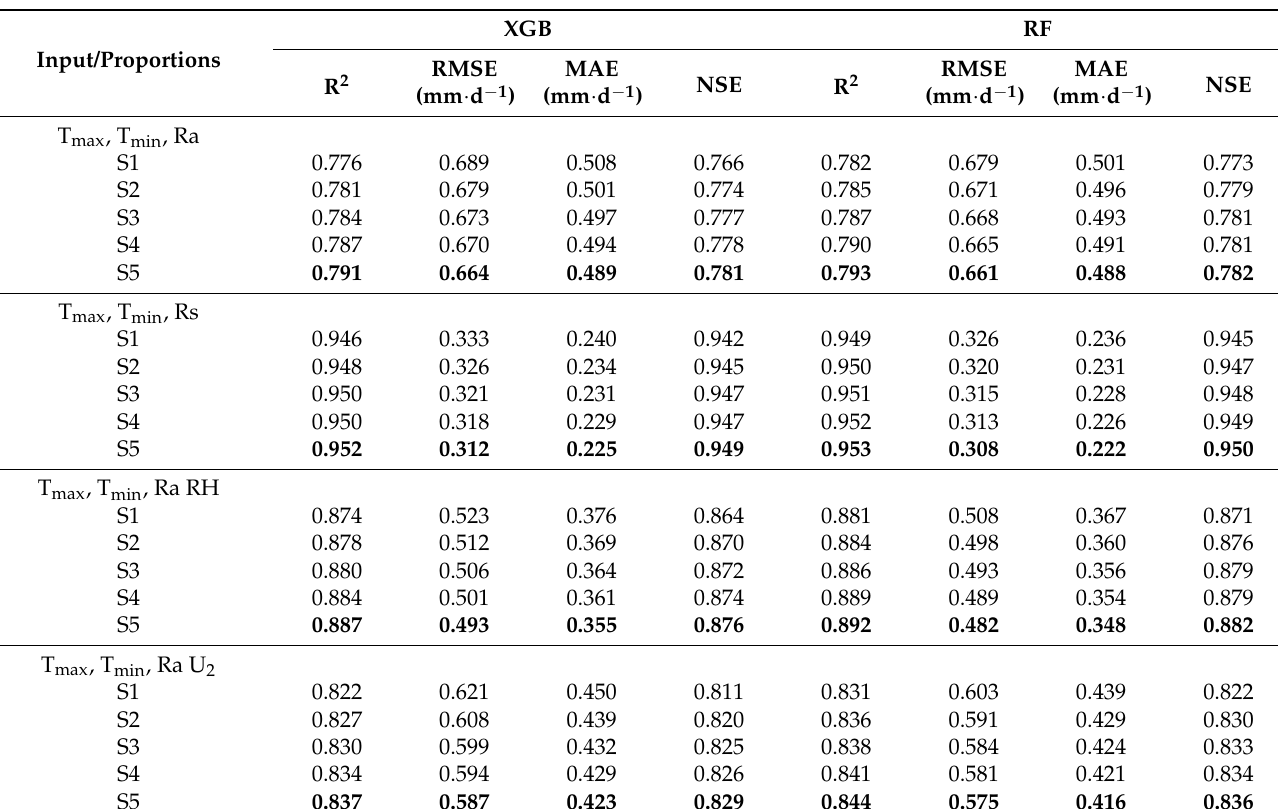
Table 5. Average statistical values of five proportions of different input parameters of two machine learning models in the testing process of 21 stations